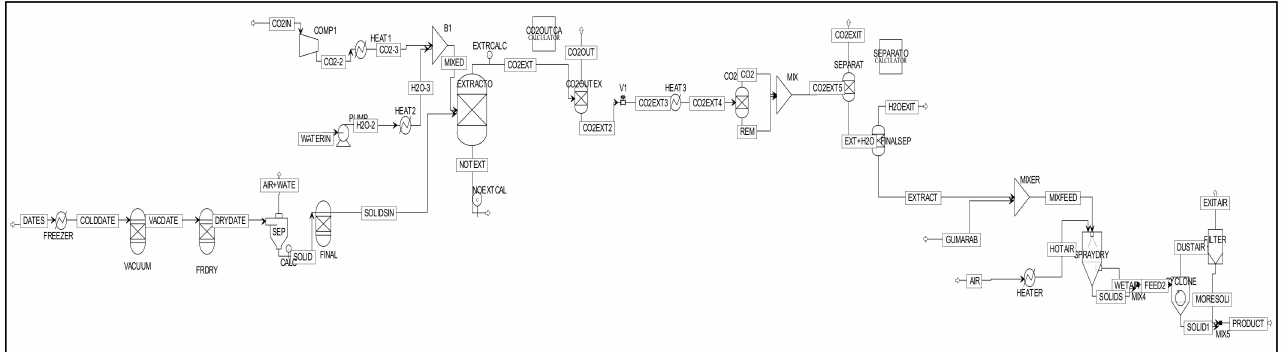
Figure 1. Integrated Date Sugar Production Process (IDSPP) flow